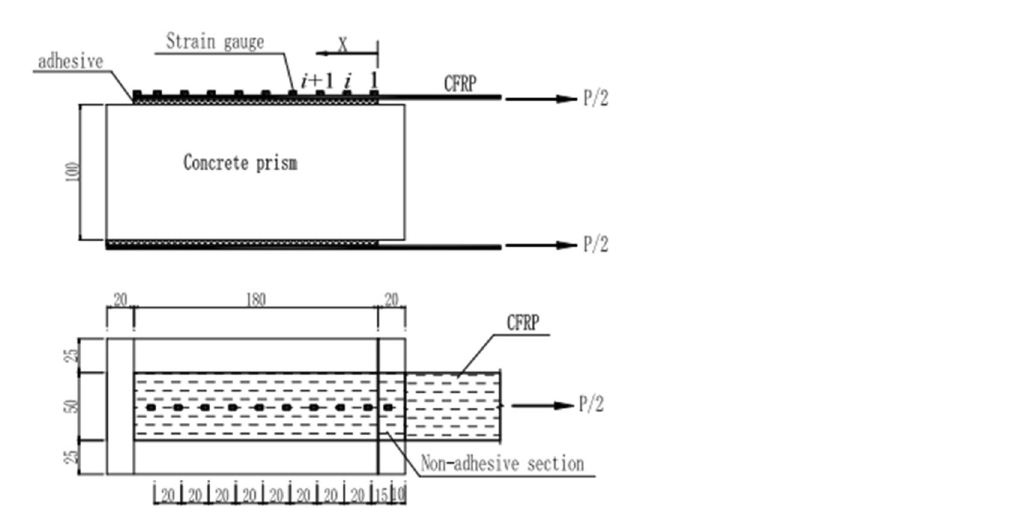
Figure 2. Specimen schematic